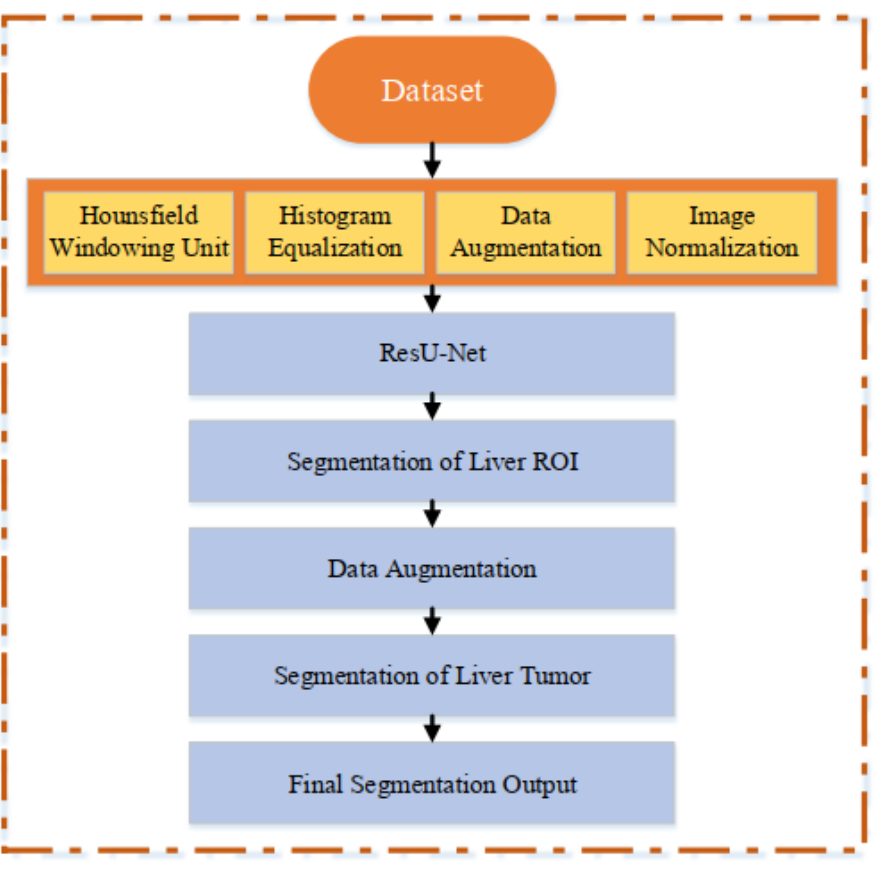
Figure 1. Overview of workflow of liver tumor